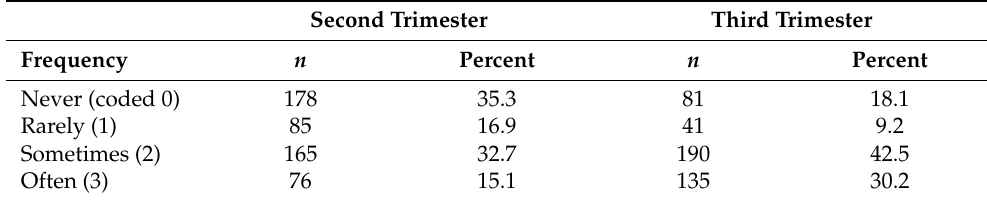
Table 5. Subjective frequency of difficulty sleeping in the second and third trimester.